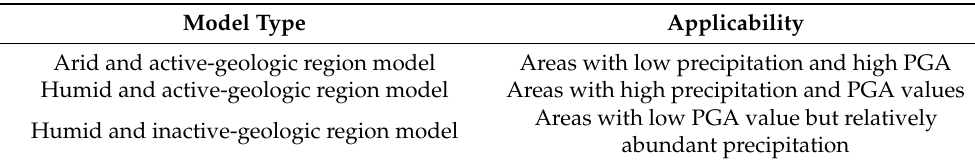
Table 2. Model classifications and applicability characteristics.